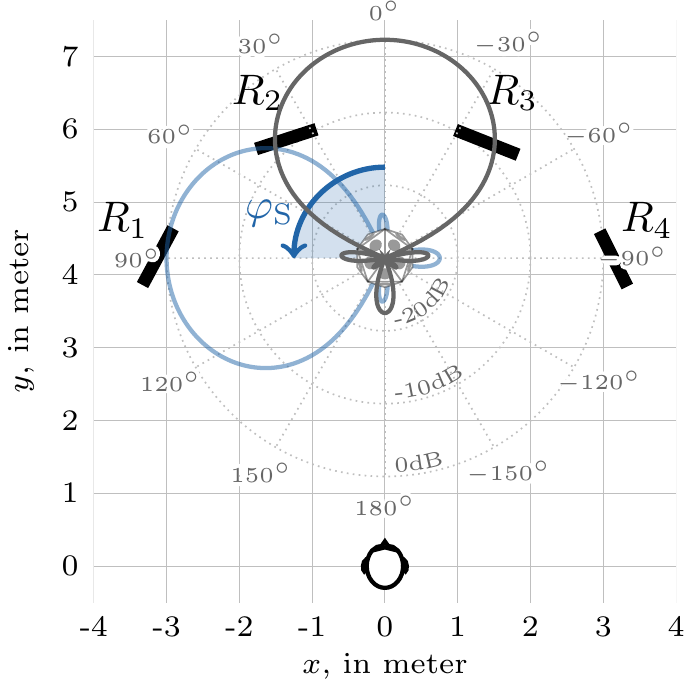
Figure 5. Position of source, listener, and reflectors (R1,..,R4) in György Ligeti Saal, Graz. An ideal 3rd-order max- r E weighted beampattern with a dynamic range of 30dB is shown in gray. For the listening experiment we used the beam directions ϕ S = [ 0 ◦ ,180 ◦ ,90 ◦ ,45 ◦ , − 36 ◦ , − 82 ◦ ]